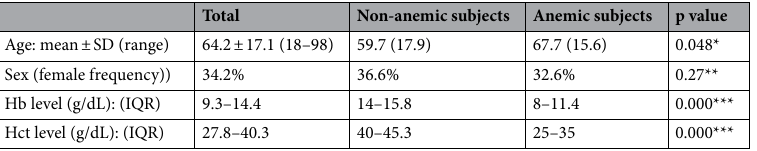
Table 1. Demographic and laboratory findings in 325 studied patients. Hb Hemoglobin, Hct hematocrit, SD standard deviation, IQR interquartile range. *t-student test, **Chi-square test, ***Mann–Whitney